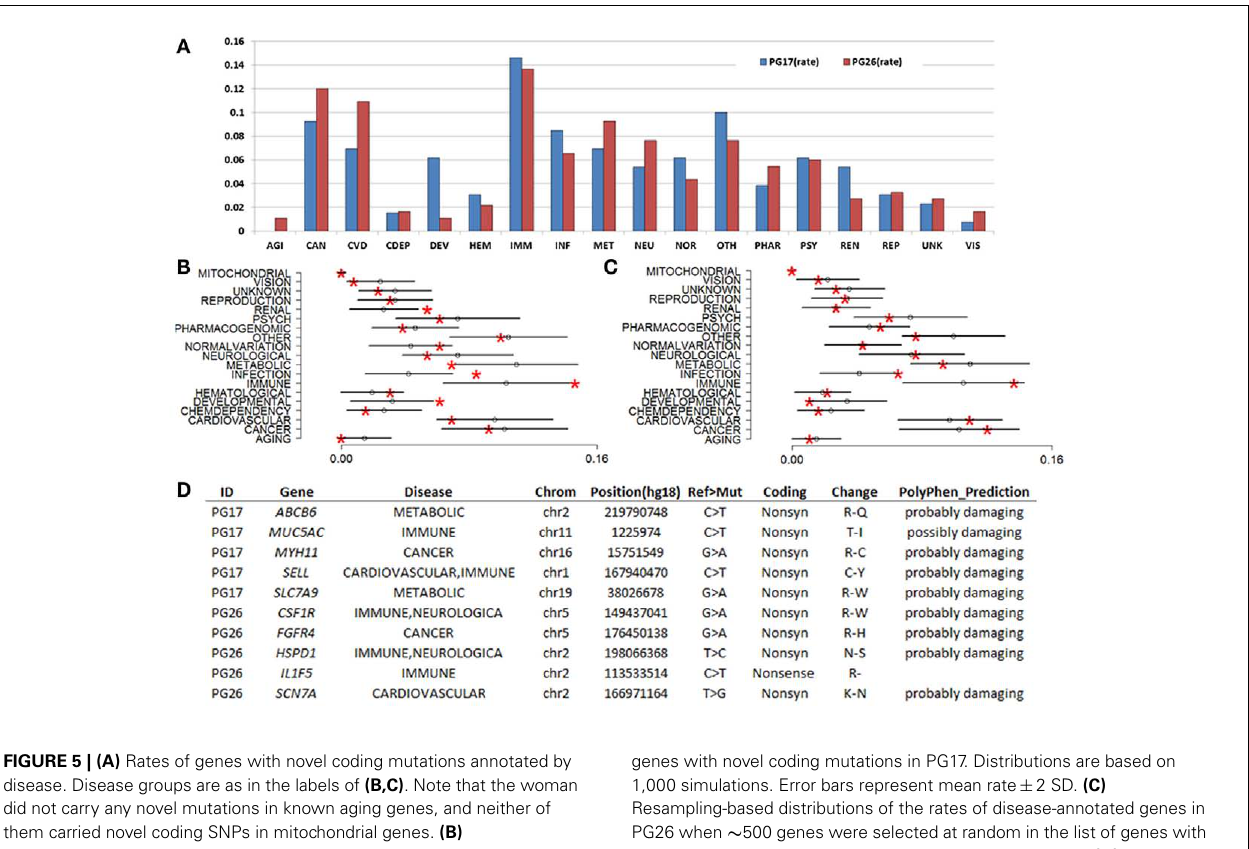
FIGURE 5 | (A) Rates of genes with novel coding mutations annotated by disease. Disease groups are as in the labels of (B,C) . Note that the woman did not carry any novel mutations in known aging genes, and neither of them carried novel coding SNPs in mitochondrial genes. (B) Resampling-based distributions of the rates of disease-annotated genes in PG17 when ∼ 400 genes were selected at random from the list of genes with coding SNPs. Red asterisks display the rate of disease-annotated